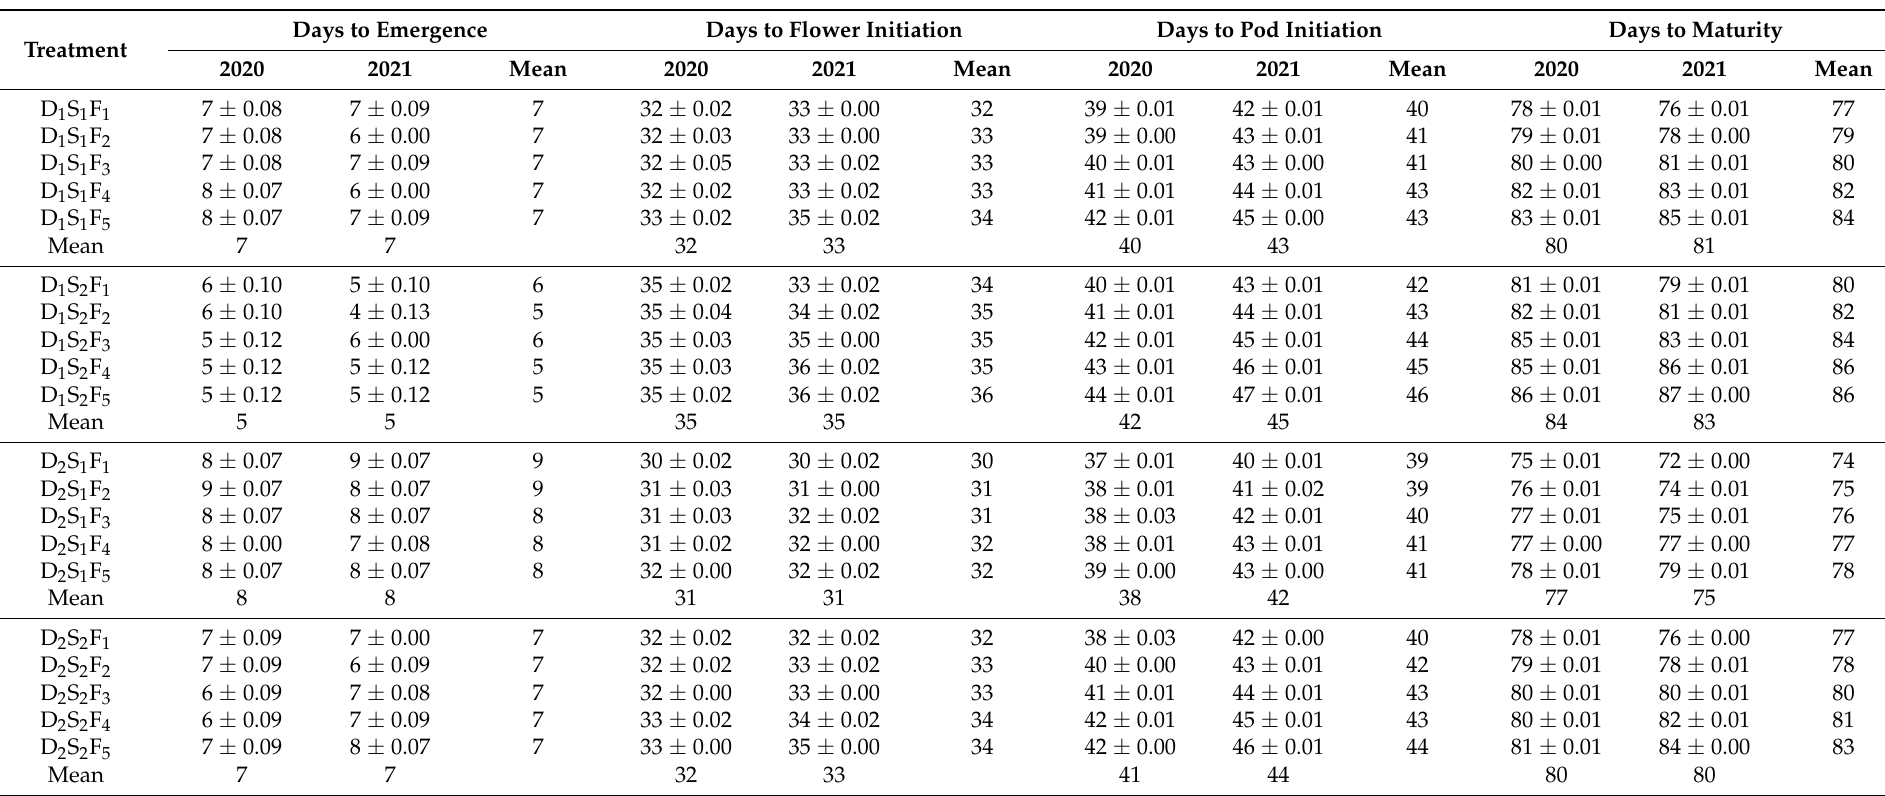
Table 4. Effect of the date of sowing, soil application of Co, and foliar spray with K and B on the phenology of black gram during the spring–summer season.